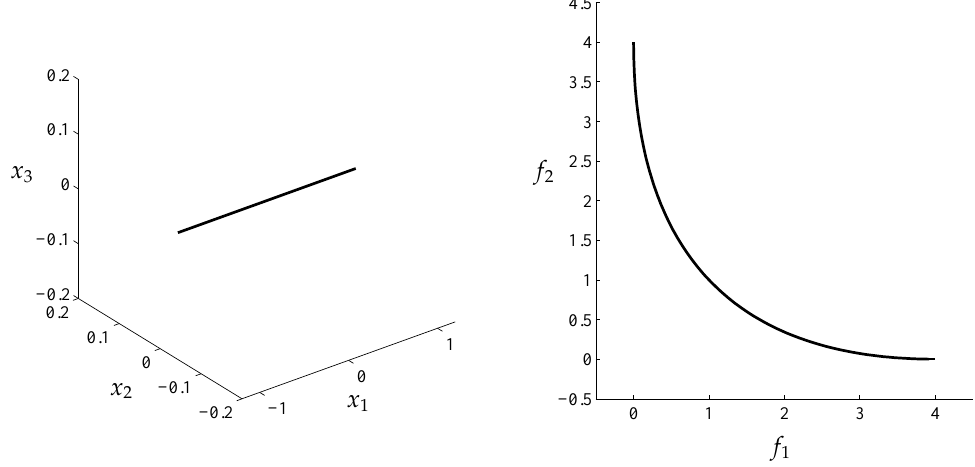
Figure 22. ( Left ) Pareto set. ( Right ) Pareto front of MOP (Equation